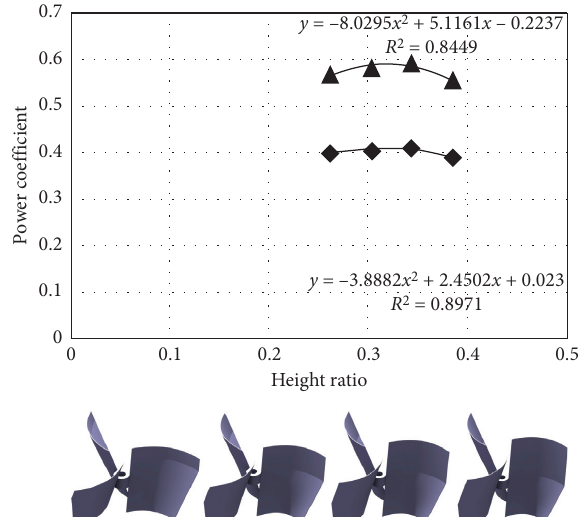
Figure 17: Set 7 data points (left to right—runners R18, R20, R21, and